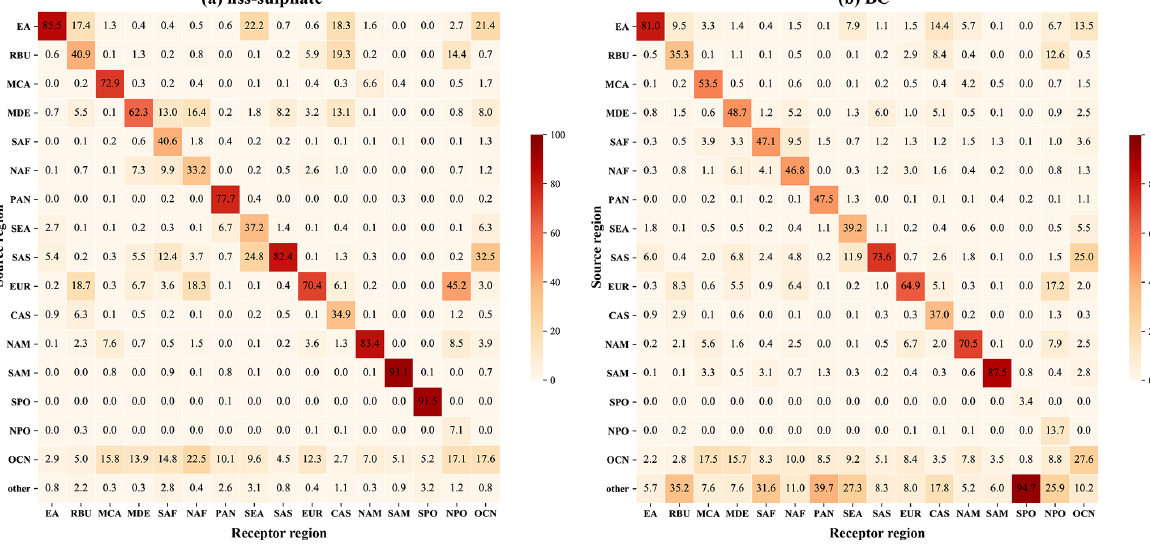
Figure 16. Annual estimates of the contributions to (a) nss-sulfate and (b) BC (%) within the PBL from source regions to receptor regions. “Other” refers to the effects of natural emissions and the boundary